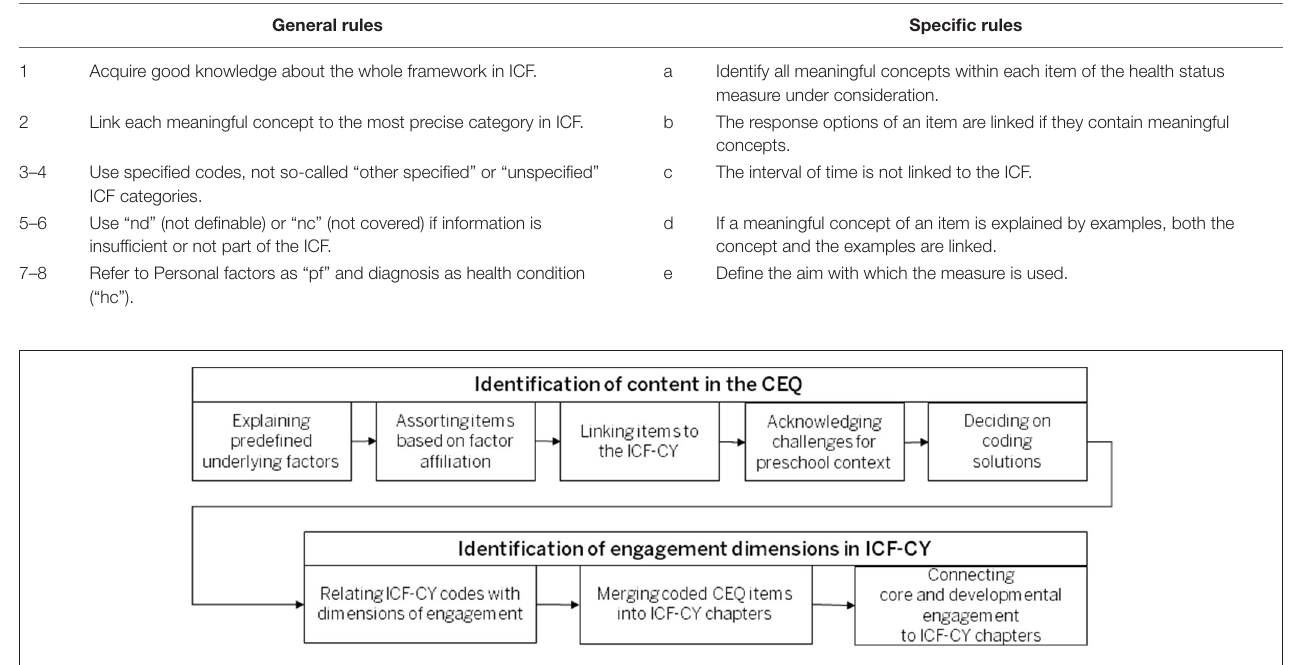
FIGURE 2 | Procedure to identify measure content and engagement dimensions. For more details about the linking process of items, see Figure 3 .